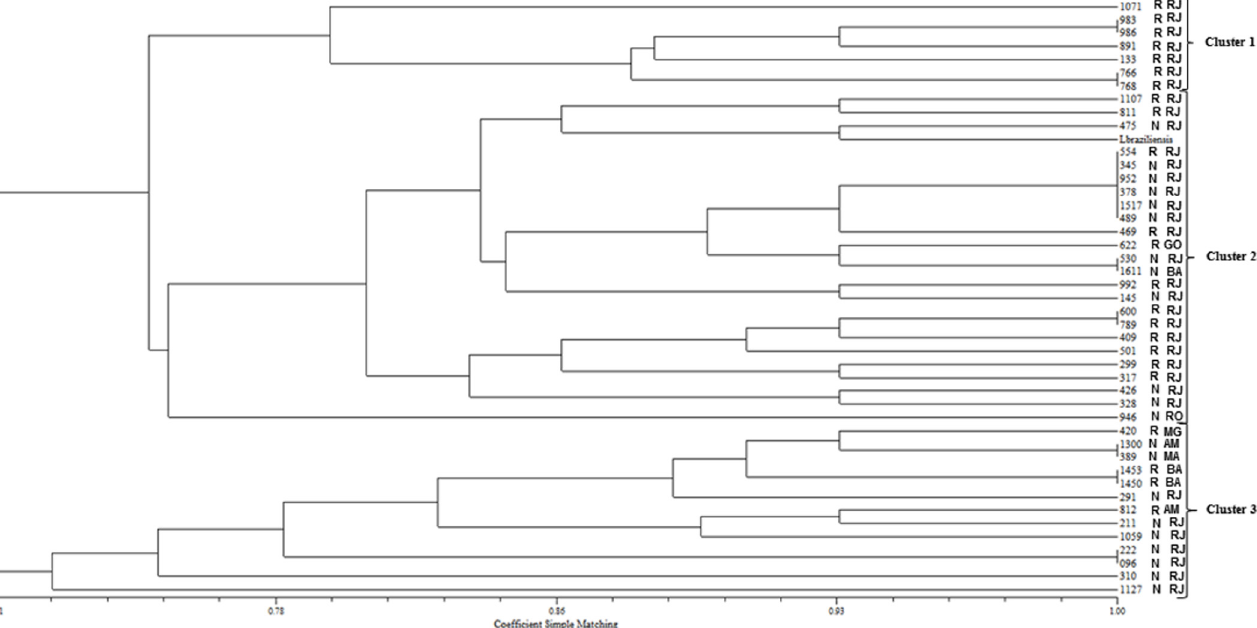
Figure 3. Phenetic analysis using the Simple Matching coef fi cient of similarity and the UPGMA algorithm. Three clusters (I, II and III) were identi fi ed. The L. (V.) braziliensis sample indicated in cluster II is the reference strain. R =responders; N= non-responders; RJ =Rio de Janeiro; GO=Goiás; BA= Bahia; RO= Rondônia; MG= Minas Gerais; AM = Amazonas; MA